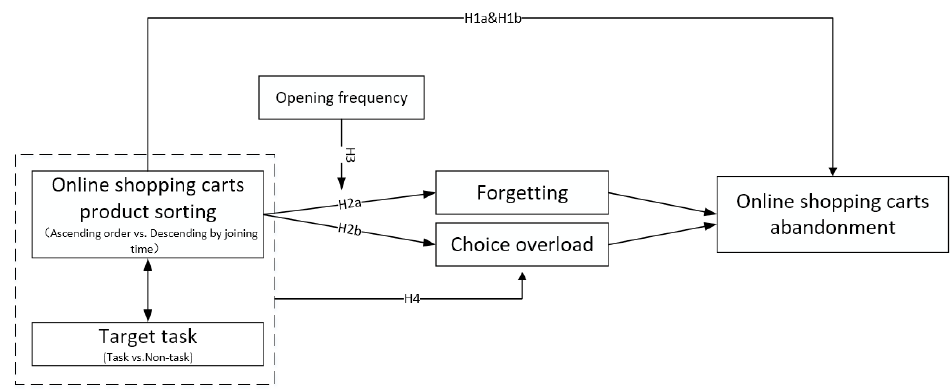
Figure 2. Research Figure 2. Research framework.